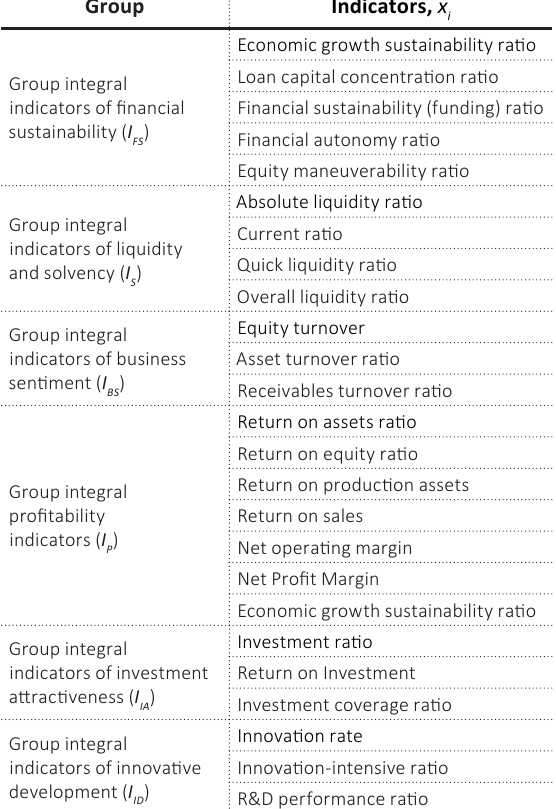
Table 1. Generalized indicators (factors) of financial and economic